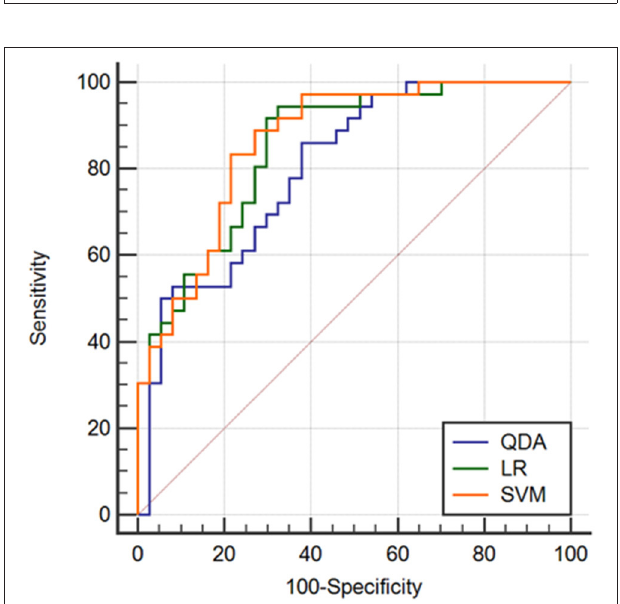
FIGURE 5 | Comparison of ROC curves derived from different machine learning